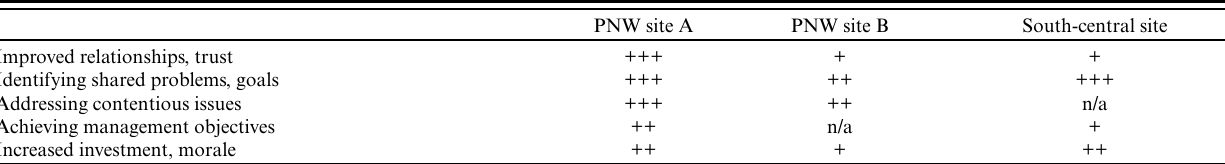
Table 2. Perceived importance of different outcomes of collaborative success.